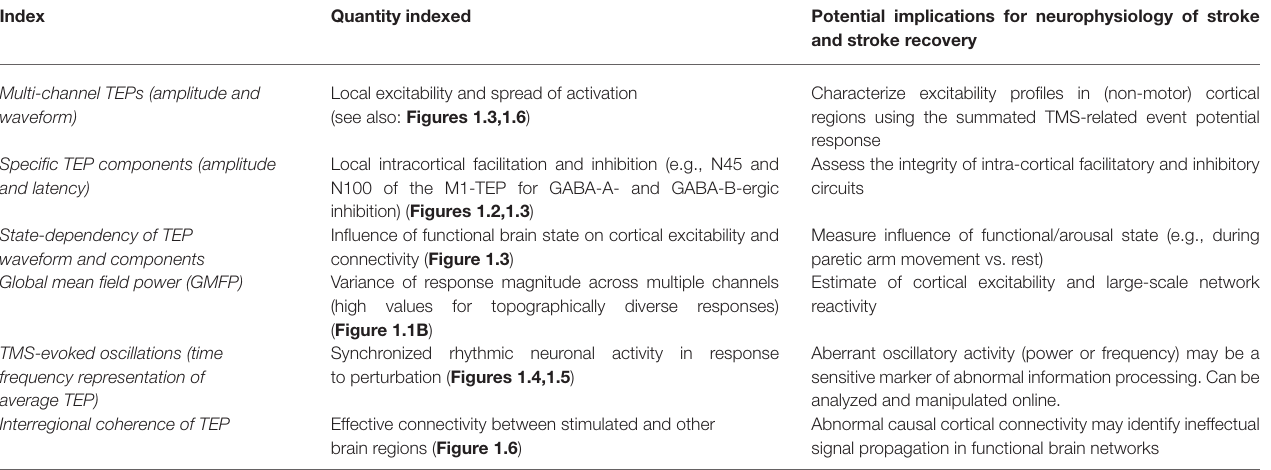
TABLE 1 | TMS-evoked potential (TEP)-based indices as possible biomarkers in stroke